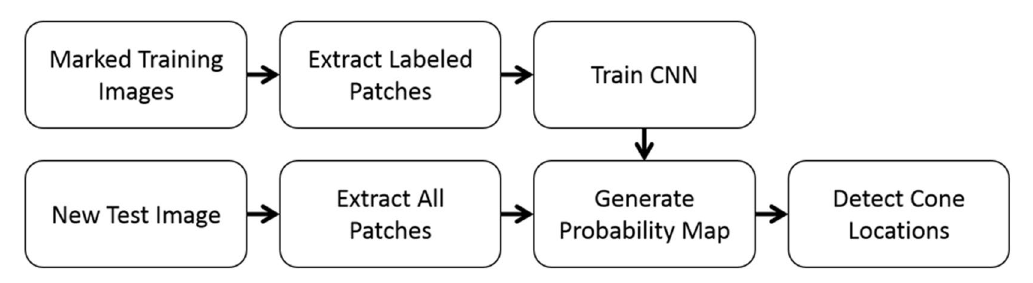
Figure 2. CNN based cone detection algorithm